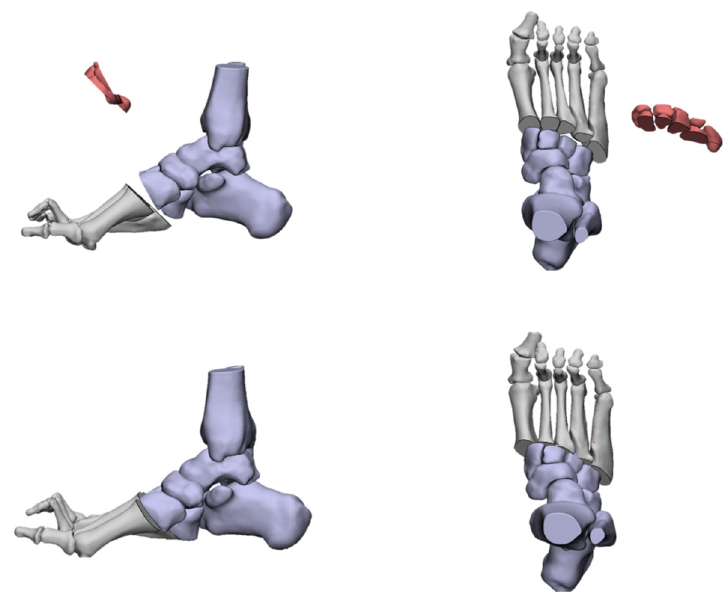
Figure 10. The Jahss Osteotomy.